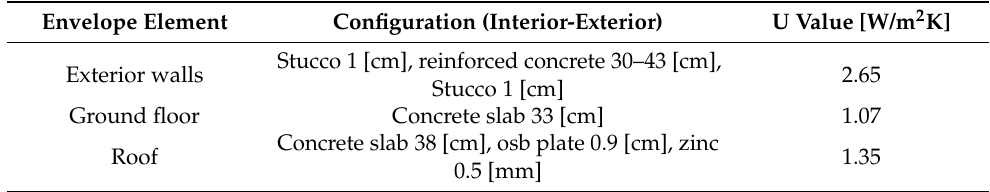
Table 1. Envelope materials characteristics.